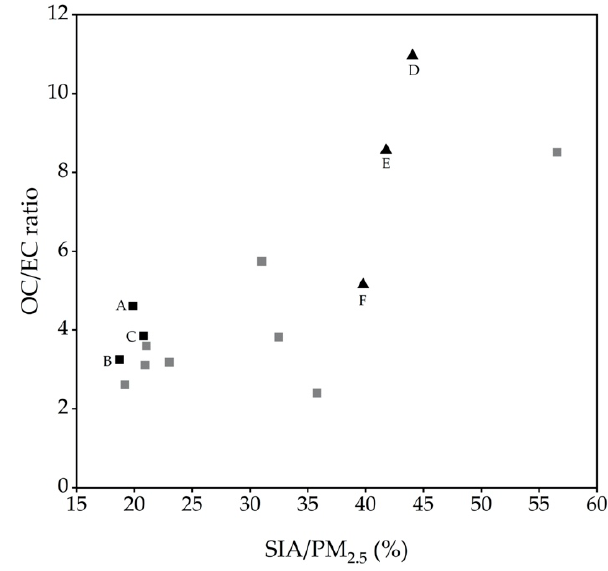
2017; C: 21 February–23 February 2017). Black highlighted triangles mark time periods with DB/BB